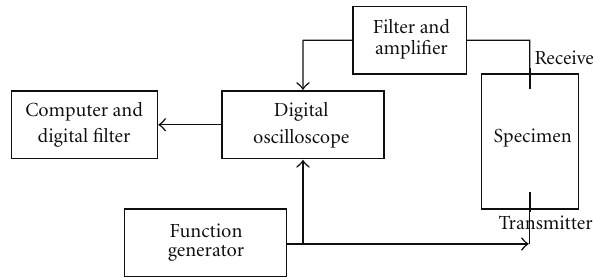
Figure 2: Blockdiagram of the test setup used for measuring V s and V ρ.